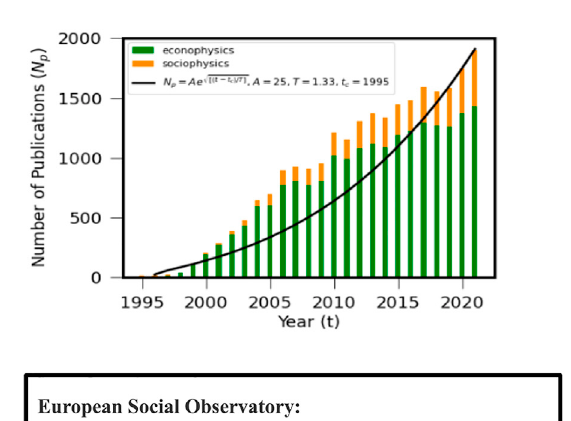
FIGURE 1 Upper left pannel: the bar-plot of the number of publications ( N p ) of the subjects, Econophysics (green) and Sociophysics (orange), throughout the years(1995 ≤ t ≤ 2021).Blacklineindicatesasub-exponential fi ttothedata.Bottomleftbox:Afailedattemptoftheproposedprojectin2011see[2] – [4]). Right bottom box: Another unsuccessful project in 2012. Upper right box: One other attempt in 2016 which has also been unfruitful till date